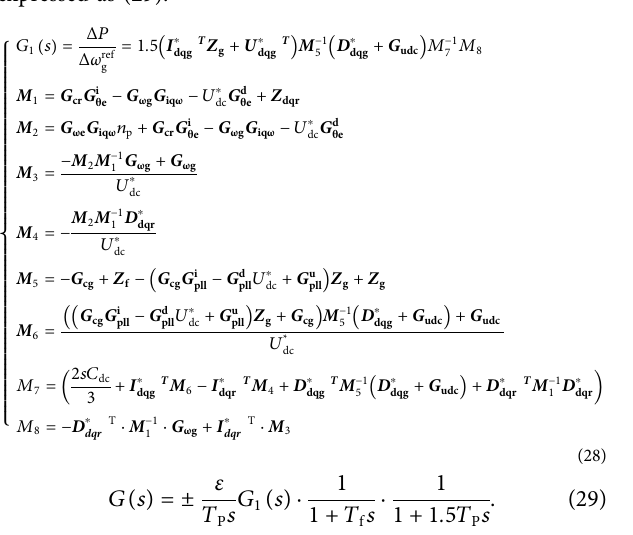
Table 2 (Geng et al., 2011), which is used in all cases unless